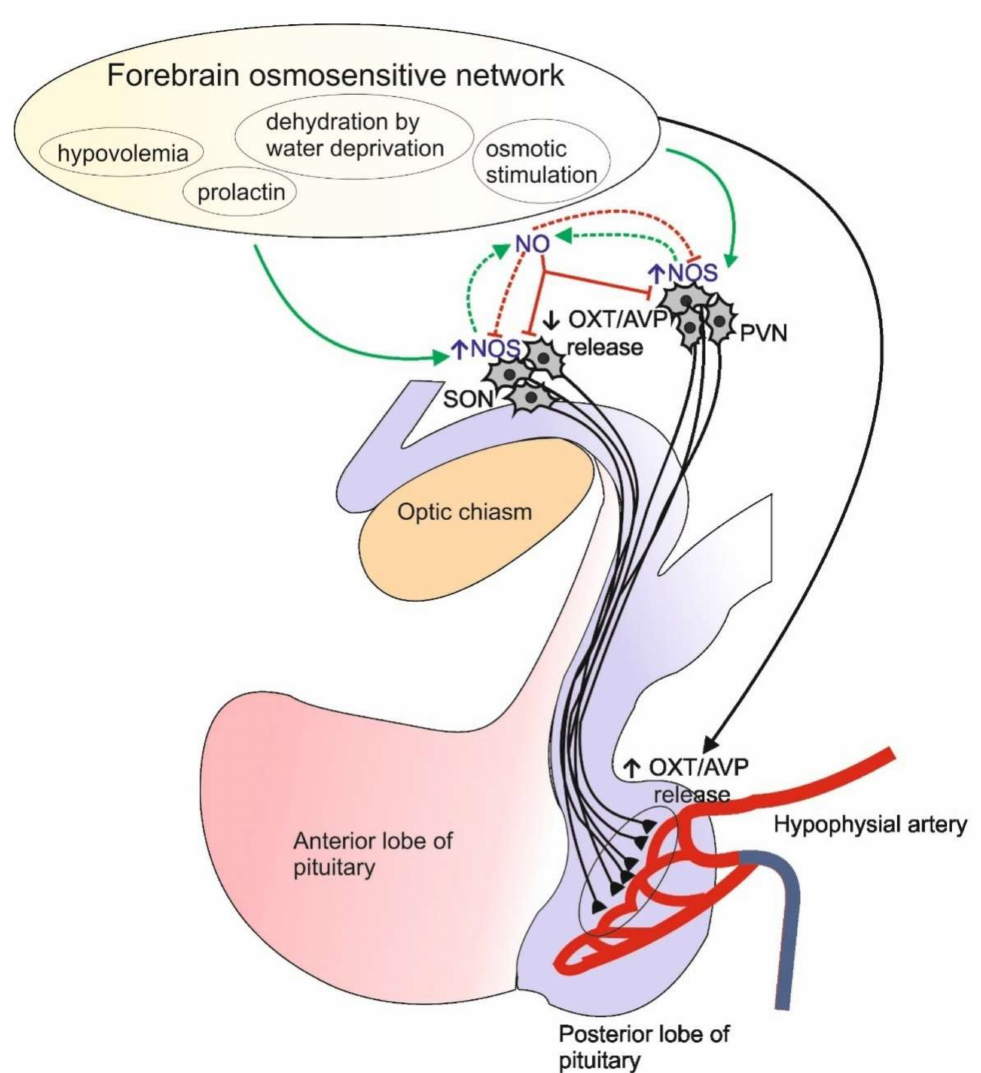
Figure 1. Schematic representation of the HNS showing the NO involvement in the modulation of AVP/OXT release following physiological and stressful stimuli. Green arrows indicate the increase in NO synthases (NOS) synthesis and/or activity; green dashed arrows indicate NO production; red lines indicate reduction of arginine vasopressine/oxytocine (AVP/OXT) release; red dashed lines indicate a putative feedback mechanism reducing NOS activity; black arrow indicates the stimulation of AVP/OXT release